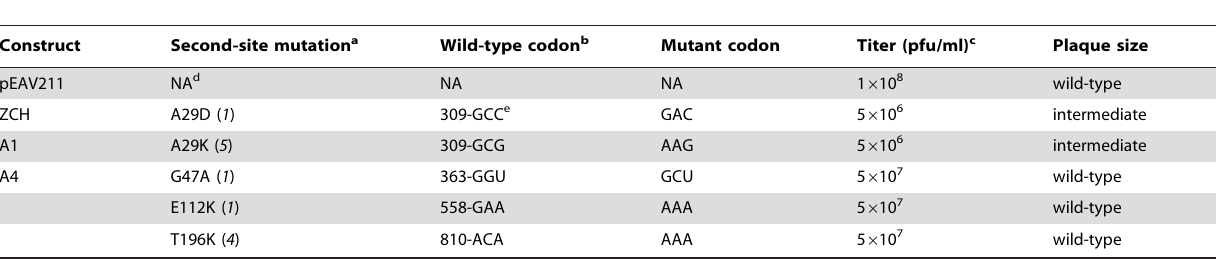
Table 3. Overview of EAV nsp1 pseudorevertants described in this study.